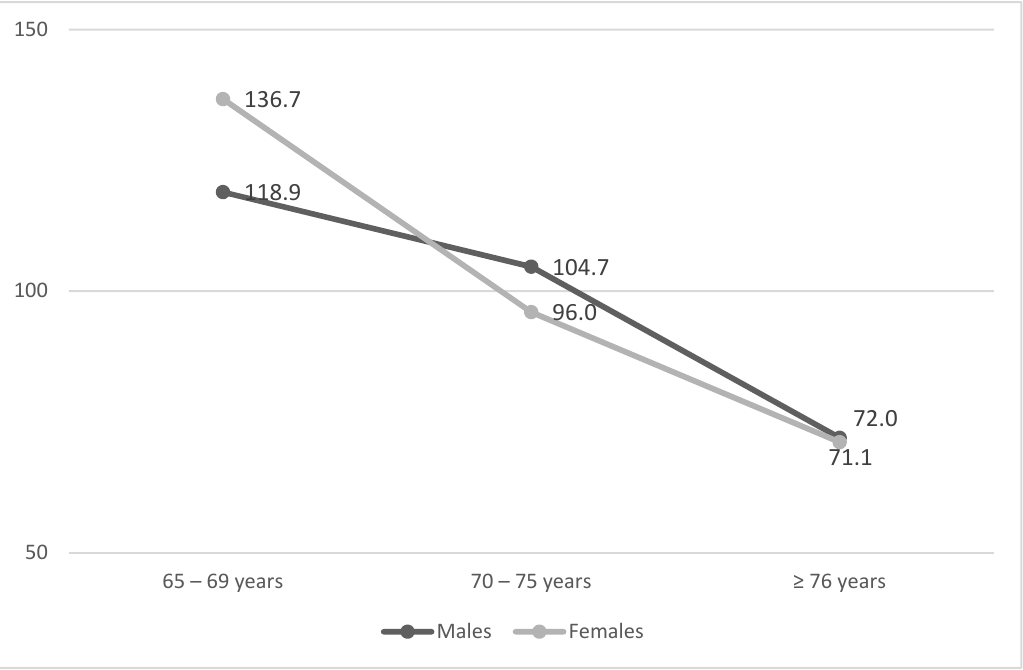
Figure 2. Total PASE scores by age group in male and female participants ( p < 0.001).